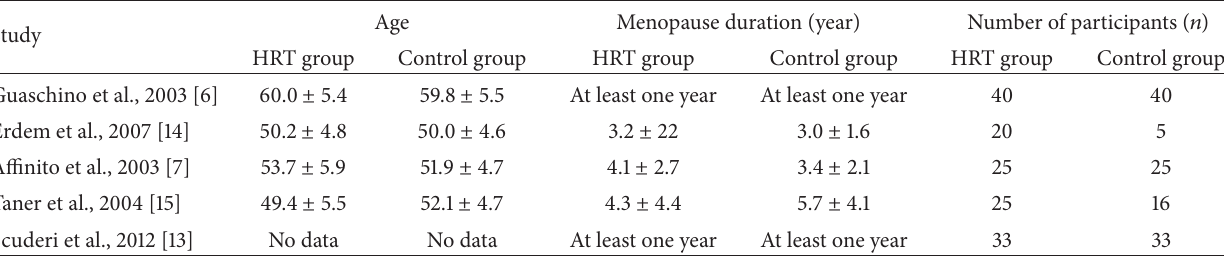
Table 2: Demographic data of the included studies.